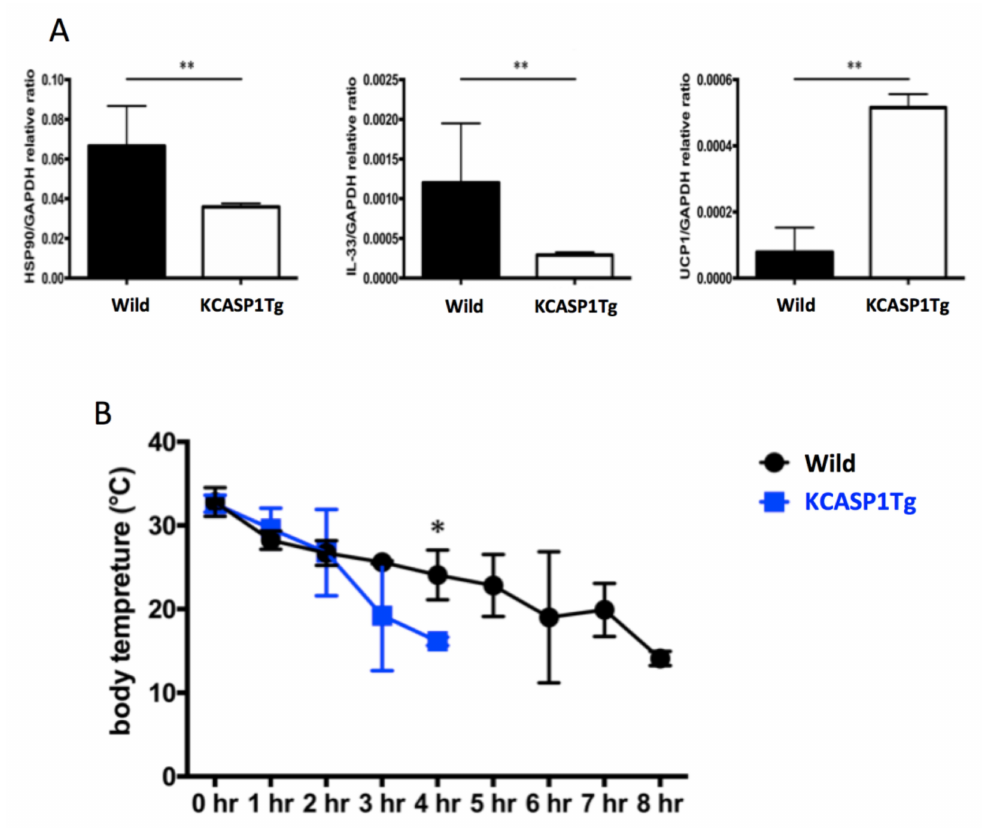
Figure 4. mRNA expression of heat-related proteins in GWAT after cold exposure. ( A ) The mRNA expression of HSP90 and IL-33 was decreased, while that of UCP1 was increased in the adipocytes of KCASP1Tg mice after exposure to 4 ◦ C ( n = 5, each group). ( B ) The body temperature of mice exposed to 4 ◦ C was measured every 1 hour using thermal imaging camera. The body temperature of the KCASP1Tg mice decreased more rapidly in a cold environment ( n = 5, each group). * p < 0.05, ** p < 0.01 versus